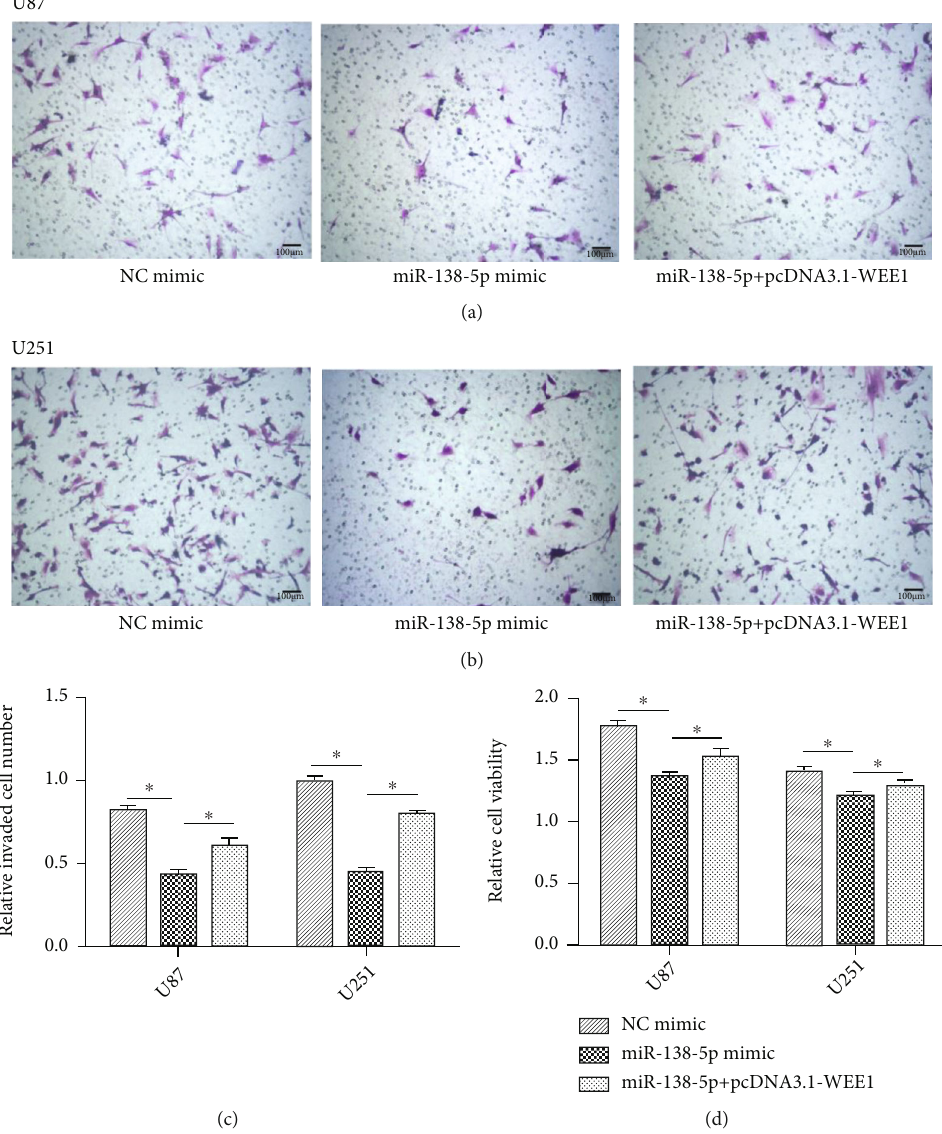
Figure 6: WEE1 expression inhibited the inhibitory e ff ect of miR-138-5p on glioma cells. (a – c) A Transwell invasion assay was used to assess the number of invaded U87 and U251 cells under various experimental conditions. (d) A CCK-8 assay was used to assess the proliferation of U87 and U251 cells in di ff erent groups. Each experiment was repeated at least three times. ∗ P < 0 : 05